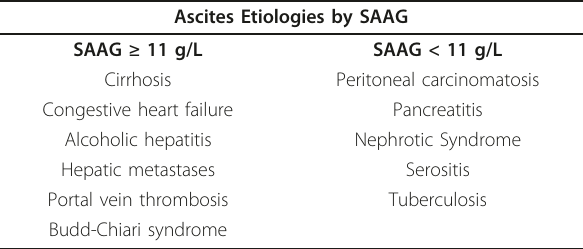
Table 1 Ascites Etiologies by Serum-Ascites Albumin Gradient